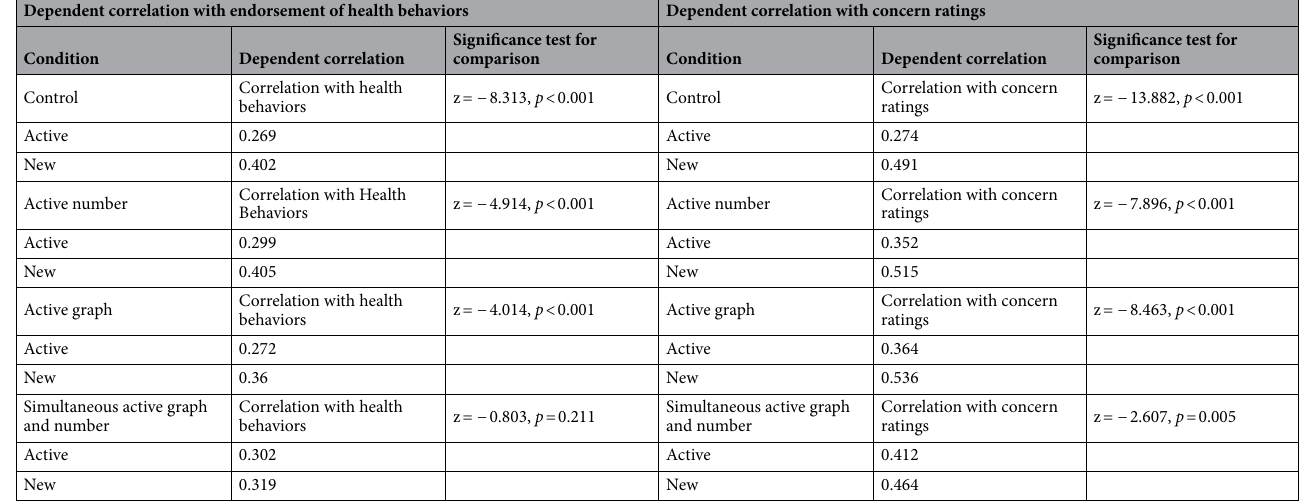
Table 2. Dependent correlation between active cases and new cases with health behaviors and concern ratings by